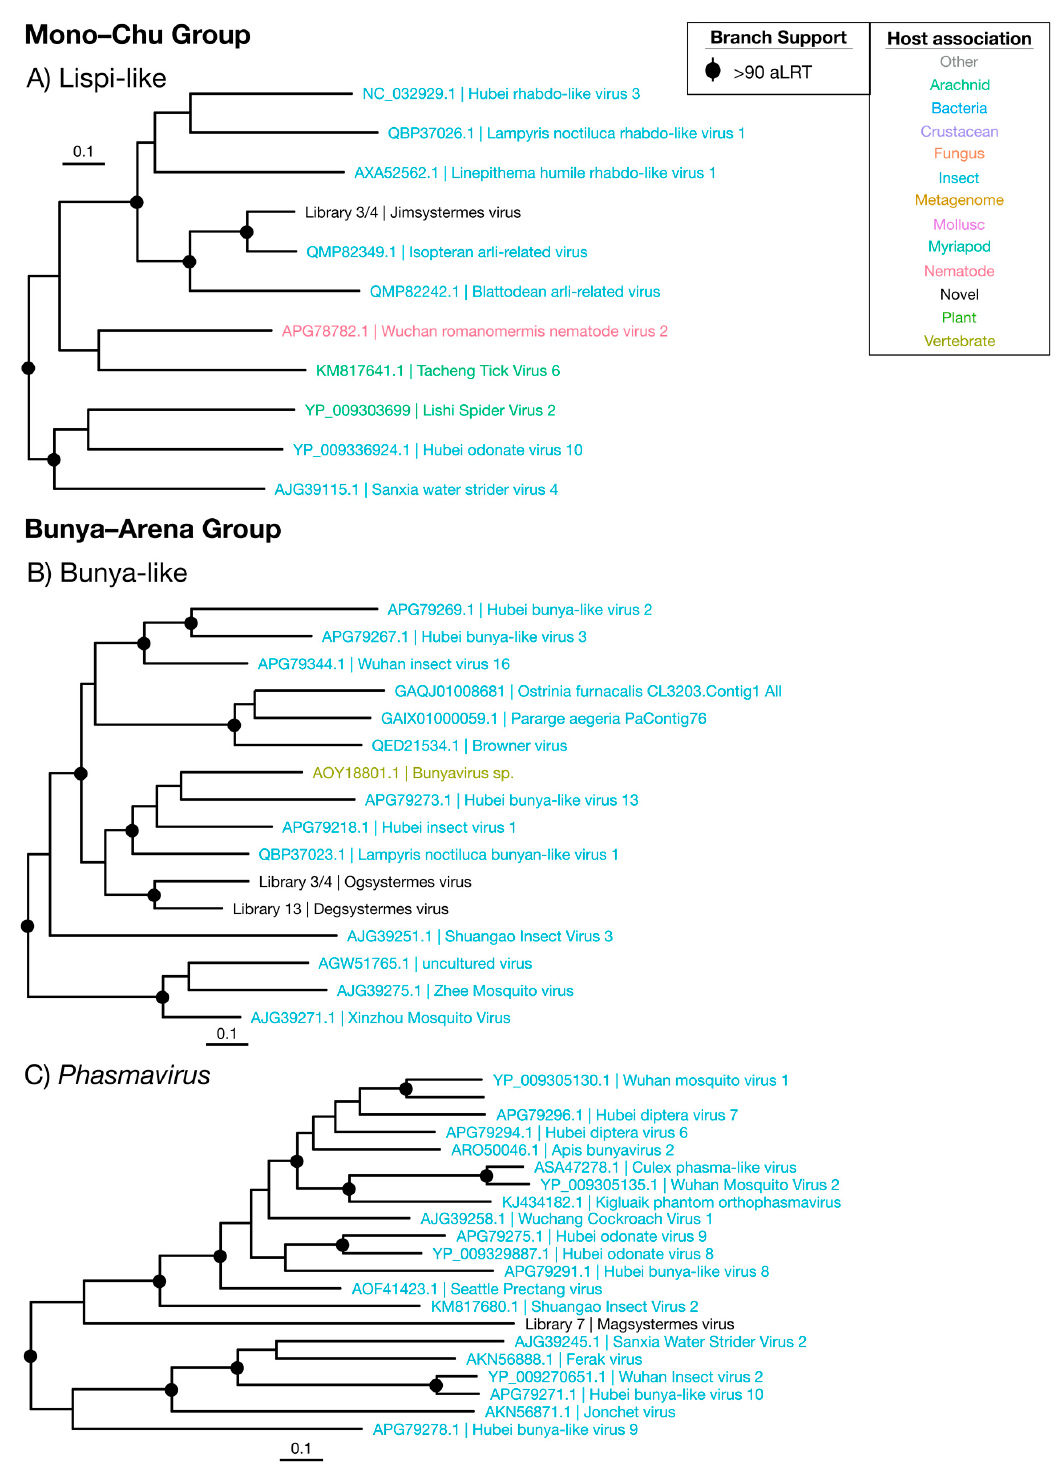
Figure 6. Phylogenetic trees of the viruses newly discovered here and their relatives in the Mono–Chu and Bunya–Arena groups. Newly identified viruses are labeled with black text in the format “ < Library # | Virus name > ”, while related viruses are colored by their host association and are labeled in the format “ < Replicase protein accession >|< Virus name > ”. Black dots at tree nodes indicate high branch support (aLRT > 90).